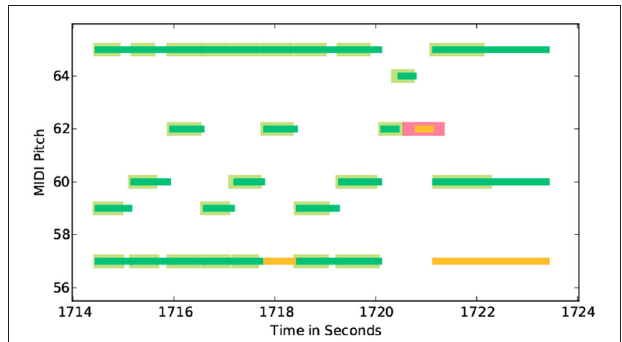
FIGURE 3 | Practice Session Work Map of an expert player (E-1)’s hour-long practice of Chopin’s “Mazurka in A minor, Op. 17 No. 4,” with Drill-Correct and Drill-Smooth sections marked in dark red and blue, respectively. Color panels in the background show the formal structure of the piece.